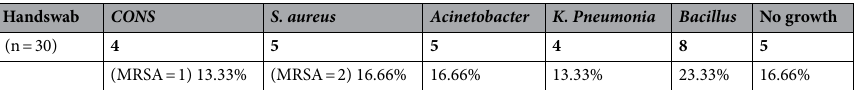
Table 6. Hand carriage of microorganism of health care workers. Organism isolated from hands of health care workers. The organisms which were isolated are CoNS (4/30), S.aureus (5/30), Acinetobacter (5/30), and K. pneumoniae (4/30 ), Bacillus